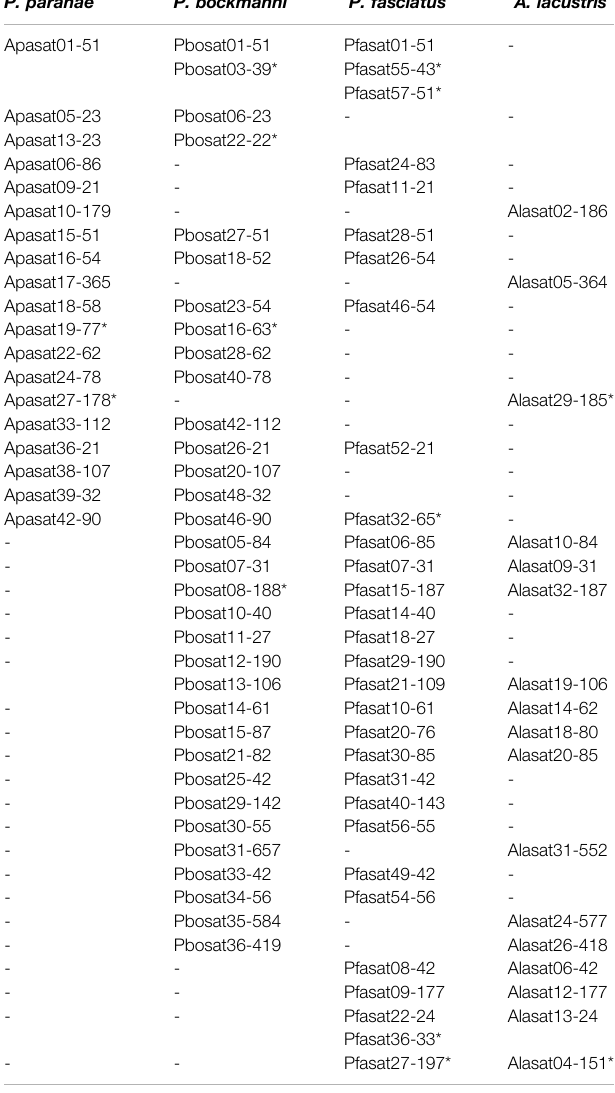
TABLE 6 | SatDNAs similarity in two or three species analyzed. Similarity in superfamilies level (between 50 and 80%) are highlighted